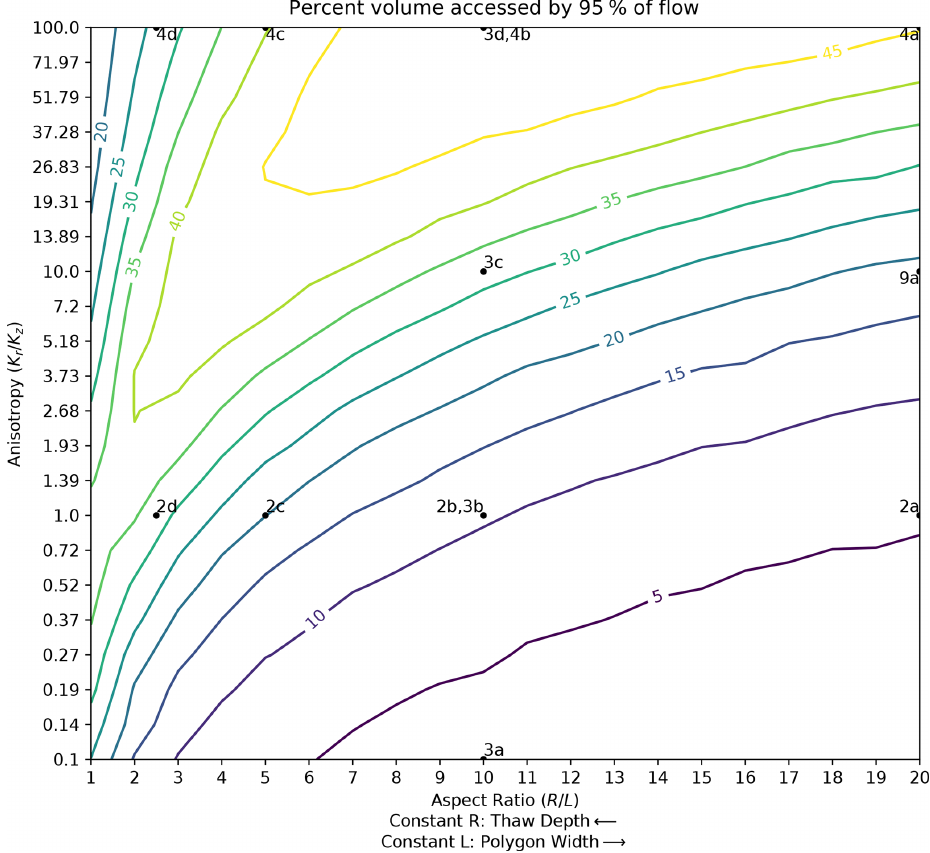
Figure 7. Contour map of the percent of the polygon access by 95% of the flow as a function of polygon aspect ratio and anisotropy coefficient. Locations associated with other figures are indicated by labeled points. By choosing a constant value for R ( L = R/x ), horizontal transects parallel to the x axis represent the effect of thaw depth increasing from right to left, while they represent increasing polygon width from left to right for constant values of L ( R = Lx ). Note that κ = 5d − 1 in these calculations and therefore the location associated with Fig. 11b cannot be